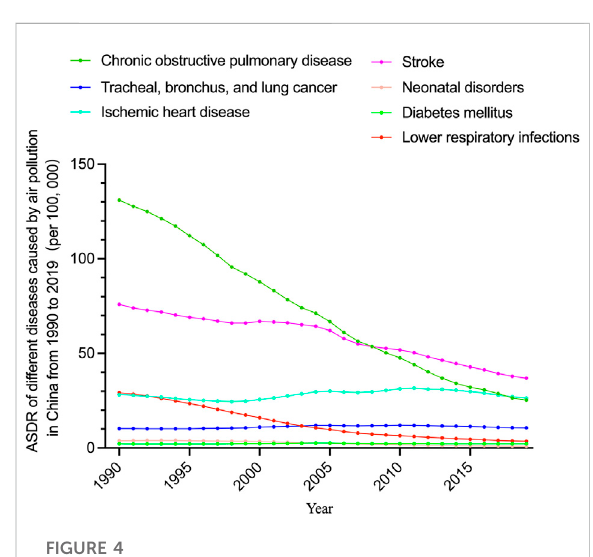
FIGURE 4 Trends of ASDR (per 100,000) of different diseases caused by air pollution from 1990 to 2019 in